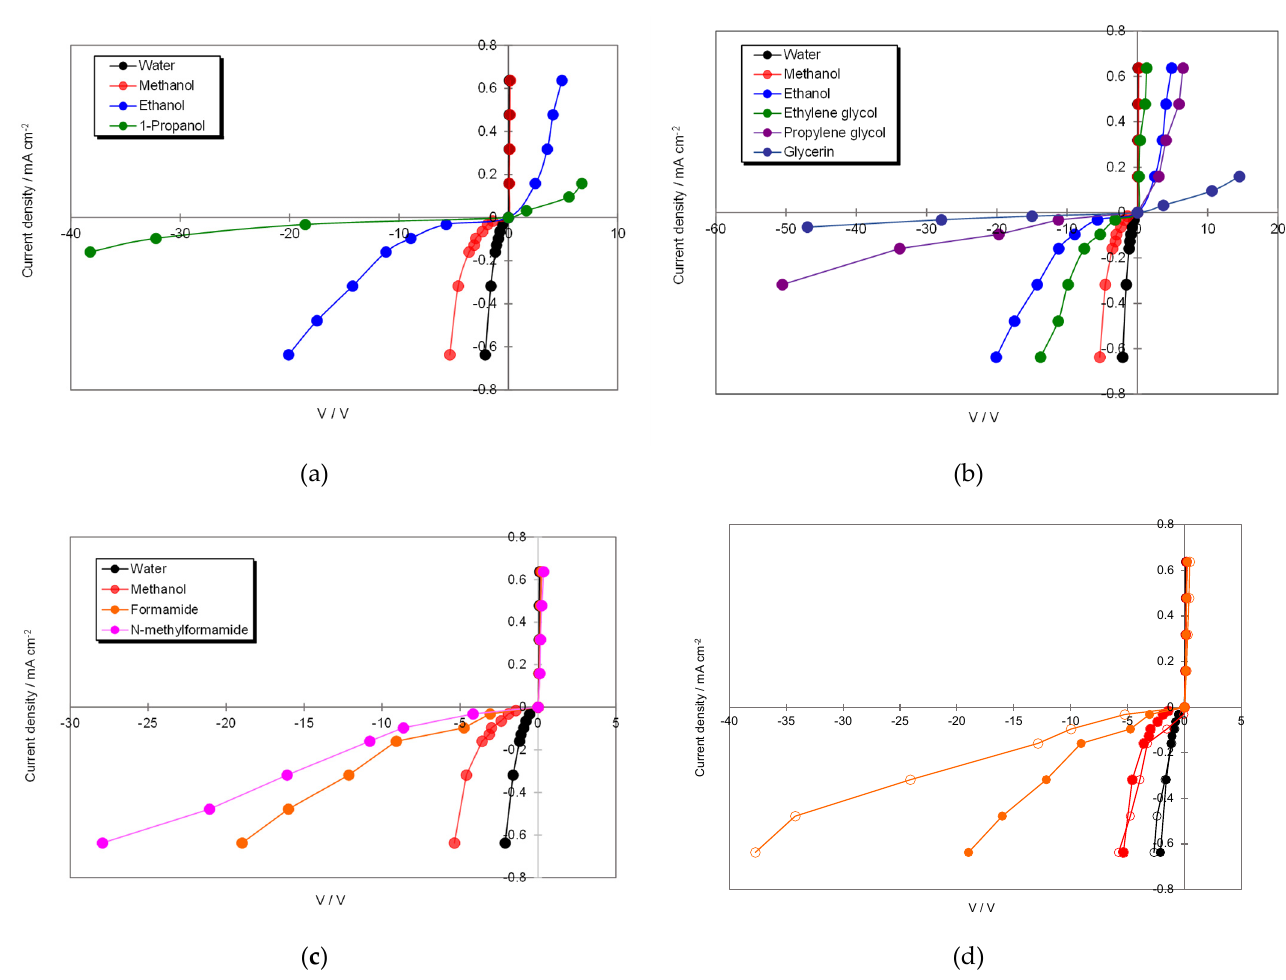
Figure 4. The current density ( J )–voltage ( V ) curves of the BPMs in ( a ) monohydric alcohols, ( b ) dihydric and trihydric alcohols, and ( c ) amides. ( d ) J – V curves of the K501/A501 BPM (solid circles) and K501/A201 BPM (open circles) in H 2 O ( ● ), MeOH ( ● ), and FA ( ● ).